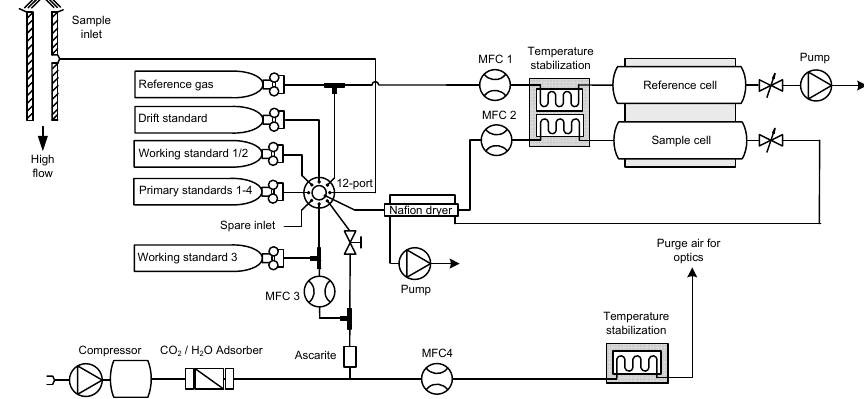
Fig. 1. Gas handling